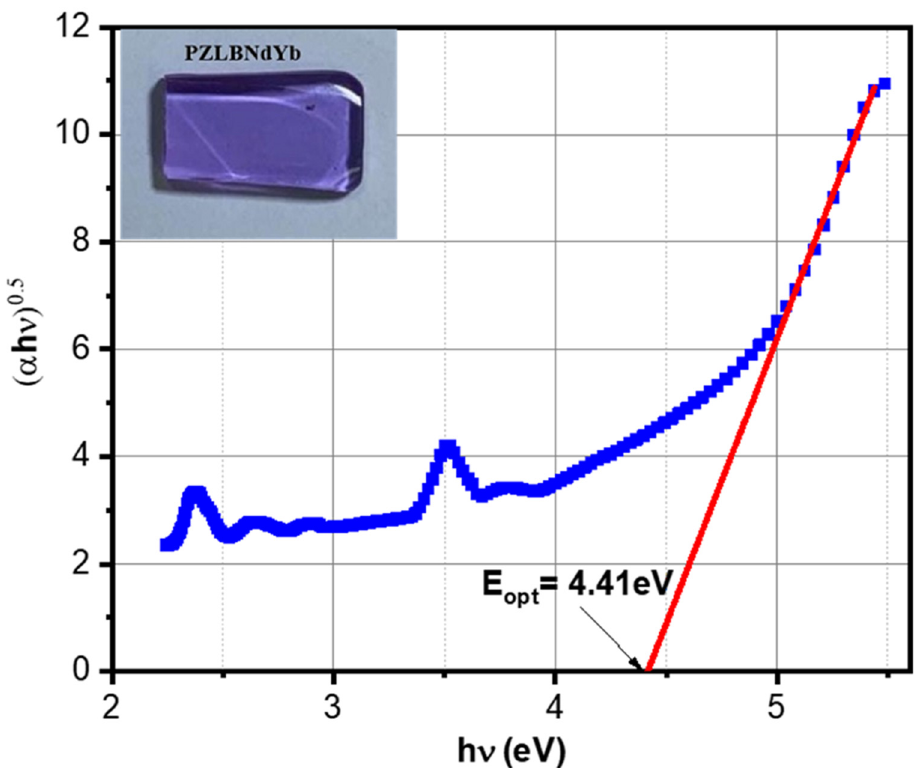
Figure 3. Relation between ( α h ν ) and ( h ν ) of the prepared glass PZLBNdYb. The measured line strength S exp ( J → J (cid:48) ) of a given band is determined by the To determine the spectroscopic parameters of this glass system, the Judd–Ofelt (JO) analysis was applied to the absorption intensities of Nd 3+ doped in PZLBNdYb. The de- tailed applications of the JO model can be found in the literature [17,18]. A brief outline of the JO analysis is given hereafter.